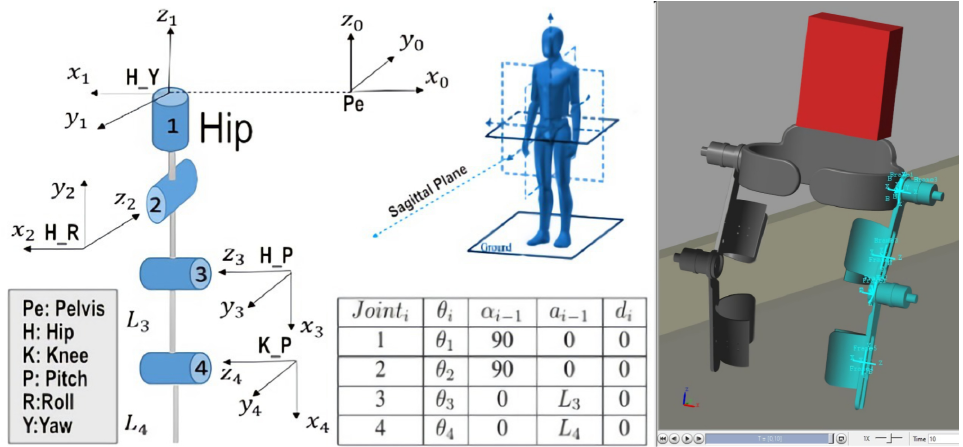
Figure 3. The DH parameters and the rehabilitation hip exoskeleton model [8].